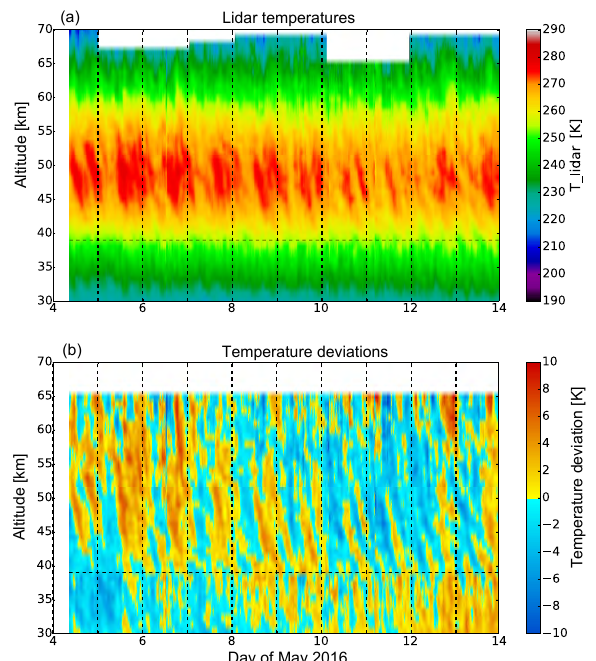
Figure 1. Temperature observed by the RMR lidar at Kühlungsborn on 4–13 May 2016 (a) and the temperature deviations from a mean temperature (b) . The horizontal dashed line indicates the transition height between different receiver